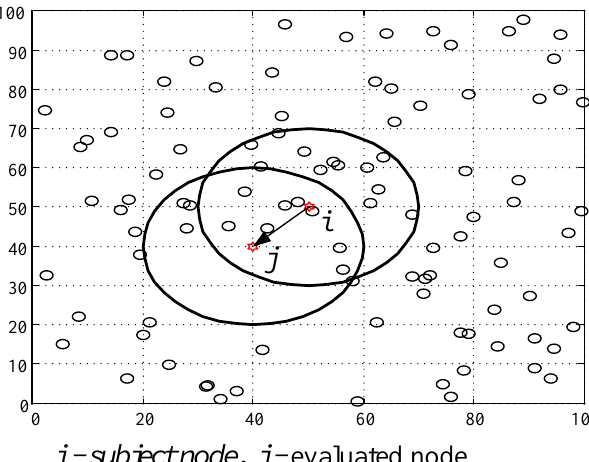
Figure 3. The distribution map of random